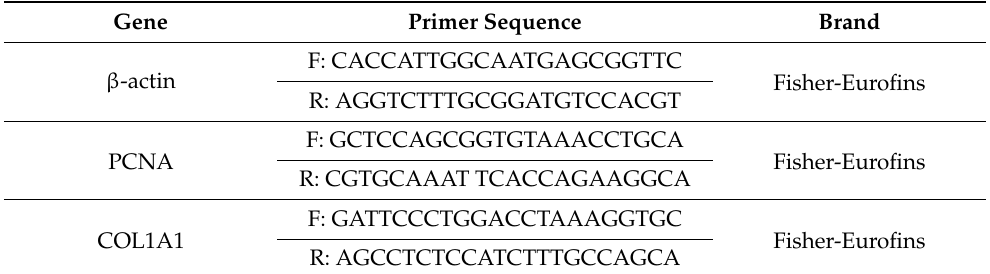
Table 5. Primers used for